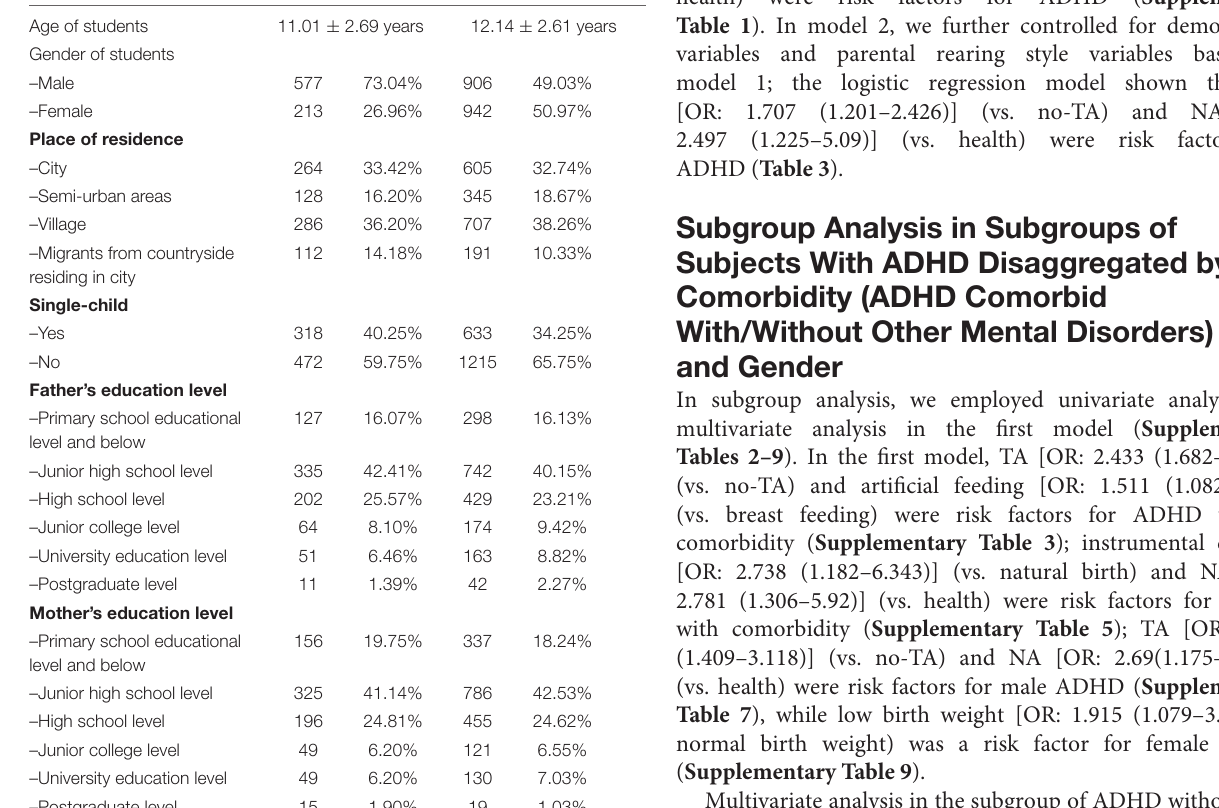
Table 7 ), while low birth weight [OR: 1.915 (1.079–3.4)] (vs. normal birth weight) was a risk factor for female ADHD ( Supplementary Table 9